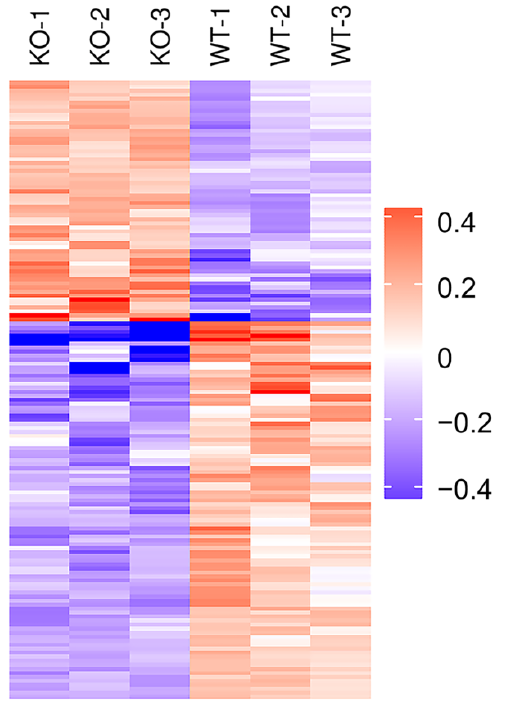
Figure 5. Cluster analysis of DEPs in Selenot -KO vs. WT group. In the heatmap, each column represents a sample (abscissa for sample information), and each row represents a protein (ordi- nate for DEPs). The expression levels of DEPs in different samples were standardized by Z-Score method and displayed in different colors. Among them, red represents significantly up-regulated proteins, blue represents significantly down-regulated proteins and gray represents proteins without quantitative